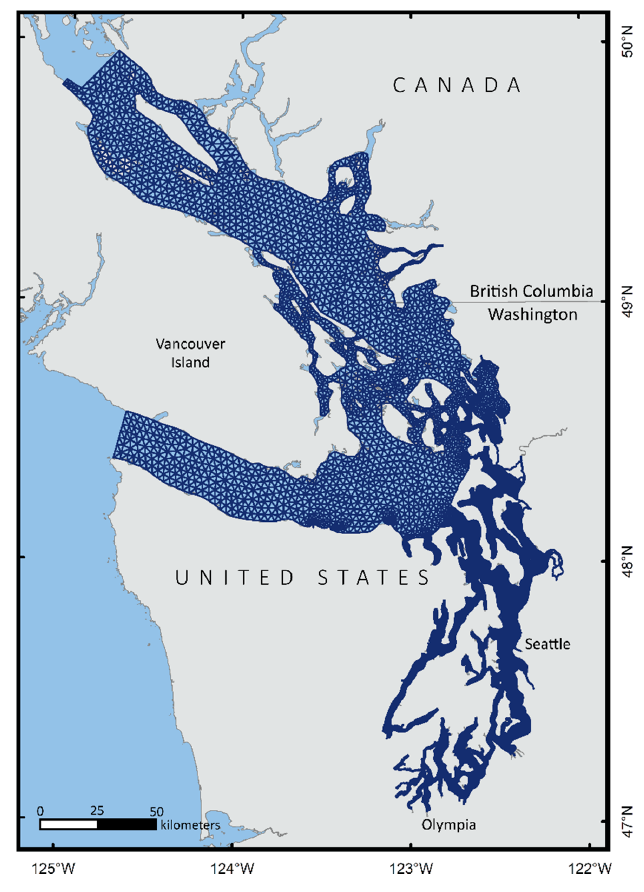
Figure 5. Extent of coverage for the Salish Sea Model.